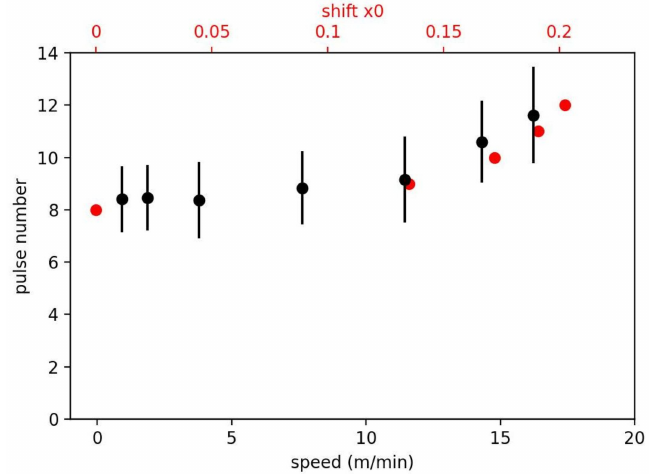
Figure 9. Experimental results of pulses needed to ablate the anode coating at different speeds of movement. For comparison, the red dots and the upper x-axis show corresponding simulated values according to Equation